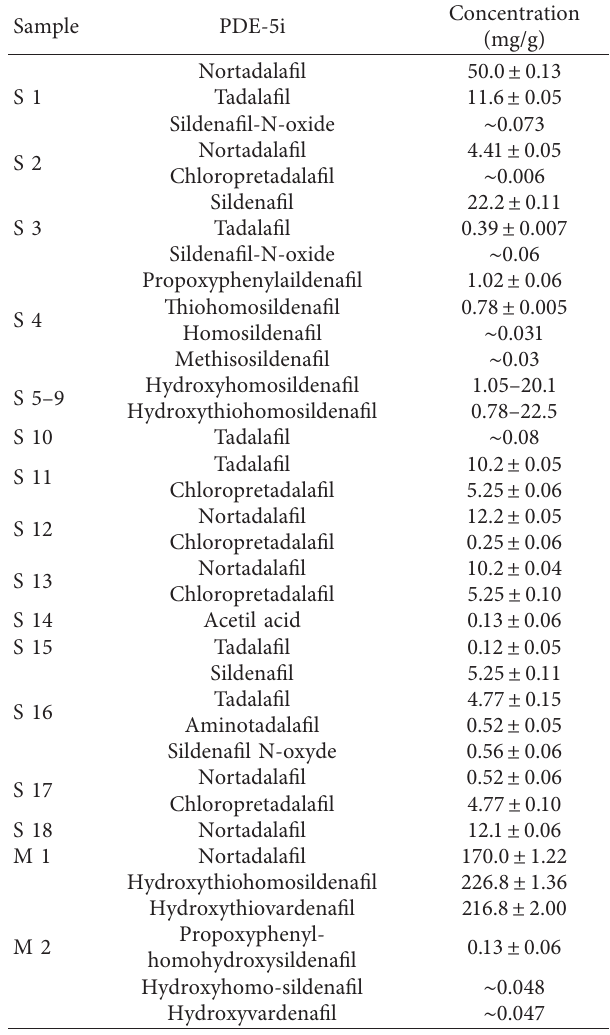
Table 3: Concentration of PDE-5i detected in real